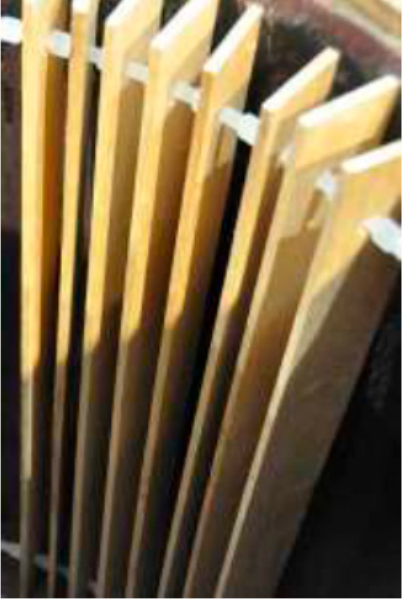
Figure 1. Stave anchoring system designed for use in exhausted barrels.